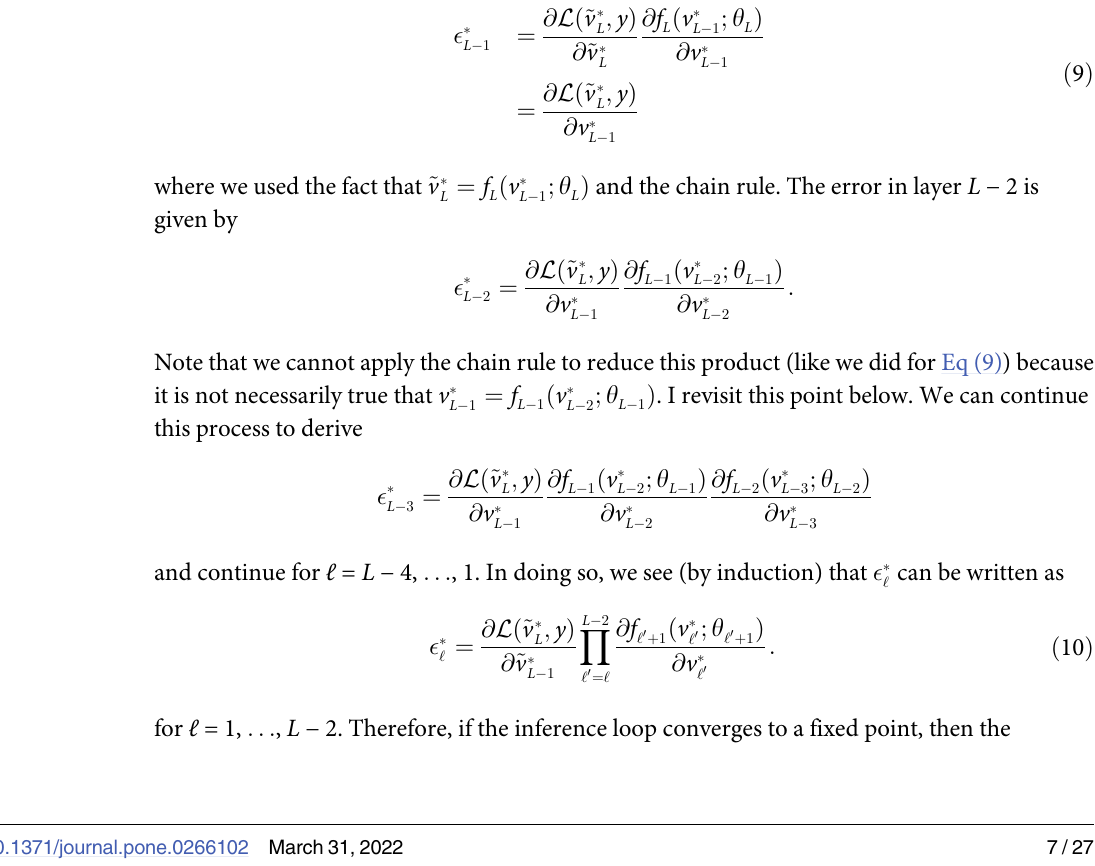
Fig 2. Comparing parameter updates from predictive coding to true gradients in a network trained on MNIST. Relative error and angle between dθ ℓ produced by predictive coding (Algorithm 2) as compared to the exact gradients, @ L =@ y were computed as a function of the number of iterations, n , used in Algorithm 2 for various values of the step size, η , using the model from Fig 1 applied to one mini- batch of data. Both models were initialized identically to the pre-trained parameter values from the trained model in Fig 1. Parameter updates converge near the gradients after many iterations for smaller values of η , but diverge for larger